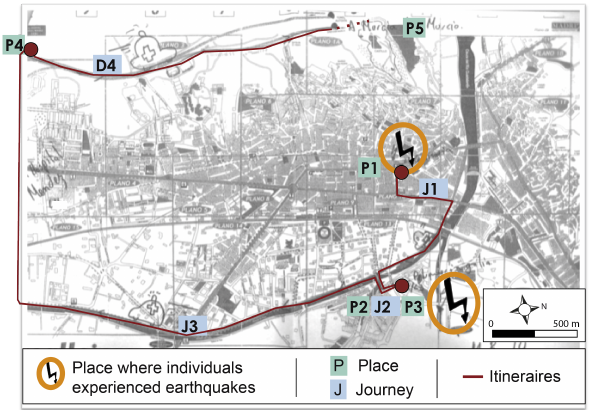
Figure 2. Example of the itinerary map drawn during one of the interviews. Base map: Lorca shopkeeper